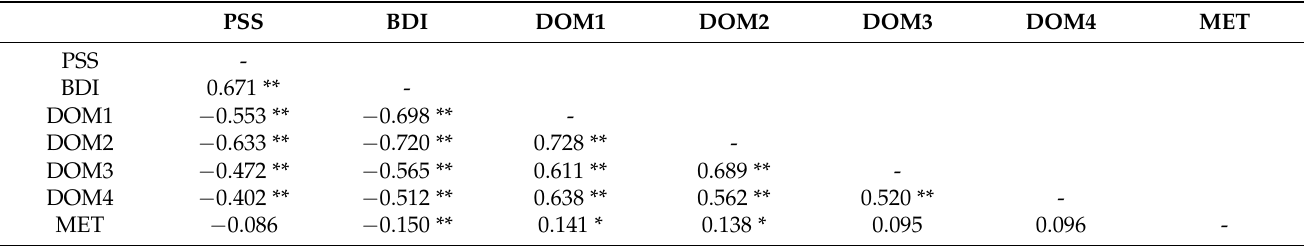
Table 4. Spearman’s Correlation Coefficient Between the Study’s